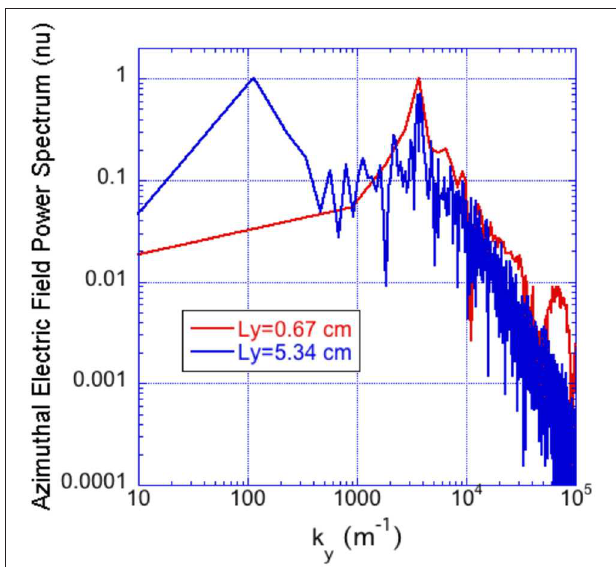
FIGURE 8 | Amplitudes (normalized to the maximum) of E y spectral components k y using two different azimuthal domain size. Results correspond to input data reported in Table 1 and using the following numerical parameters N ppc 500 and 1 y λ = D =